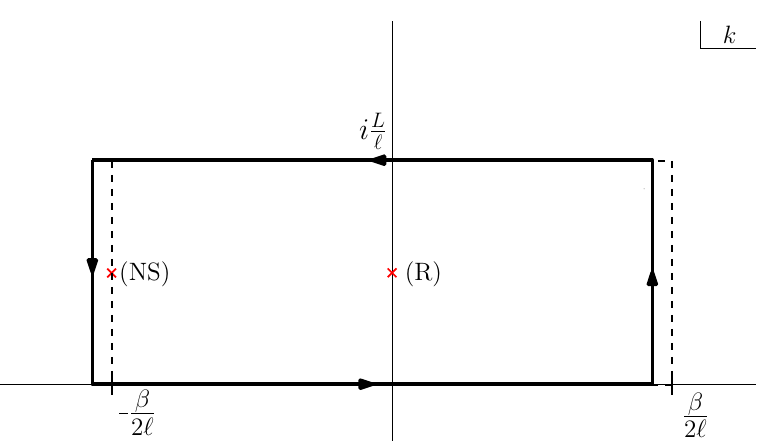
Figure 3. Integration contour of eq. (4.8). Also displayed is the pole of the integrand, which depends on the boundary